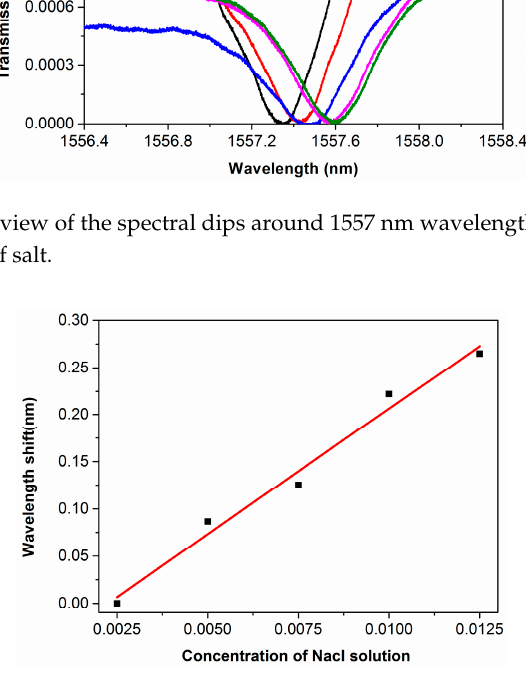
Figure 14. The wavelength shift plotted as a function of the doping concentration of salt ( black squares ), which can be well fitted with a linear relationship ( red curve ).